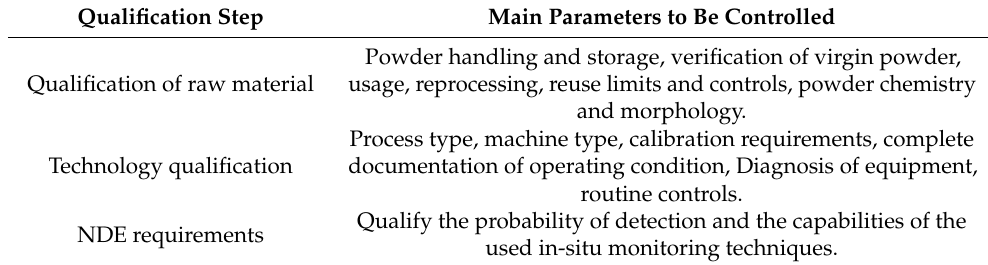
Figure 2. Five qualification sequences for additively manufactured parts. Table 2. Qualification parameters before the start of the build job.